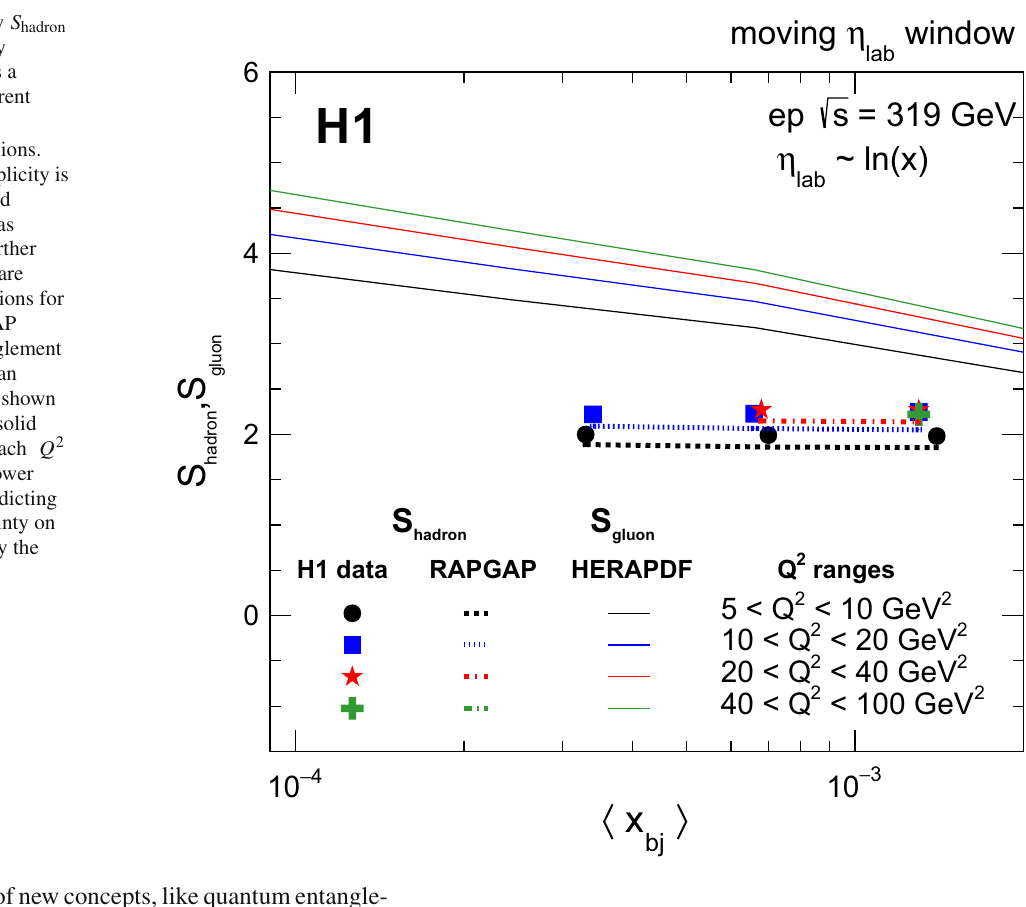
for the development of new concepts, like quantum entangle- ment at sub-nucleonic